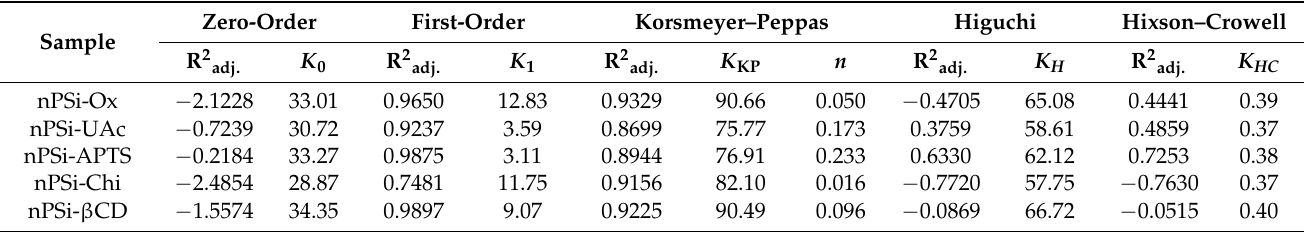
Table 2. Essential oil kinetic release models using different functionalizaties of